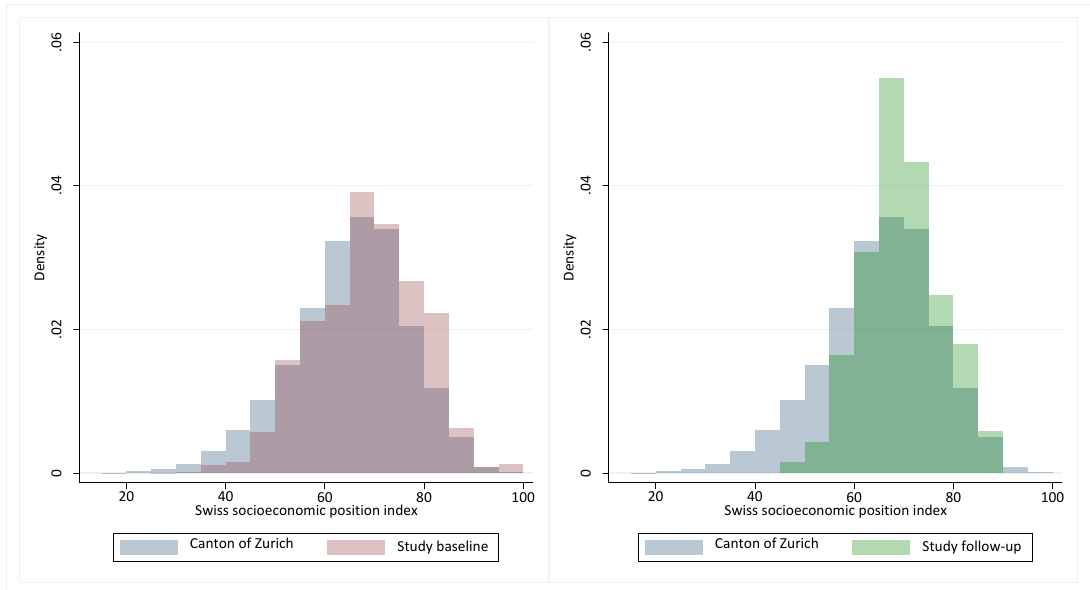
Figure S2: Histograms showing the distribution of the Swiss socioeconomic position index for families from the canton of Zurich with at least one child aged 6-17 years living in the household and in the LuftiBus in the school (LUIS) study at baseline and one-year